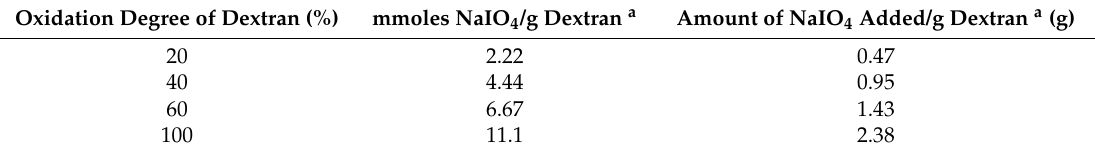
Table 5. Oxidation parameters of